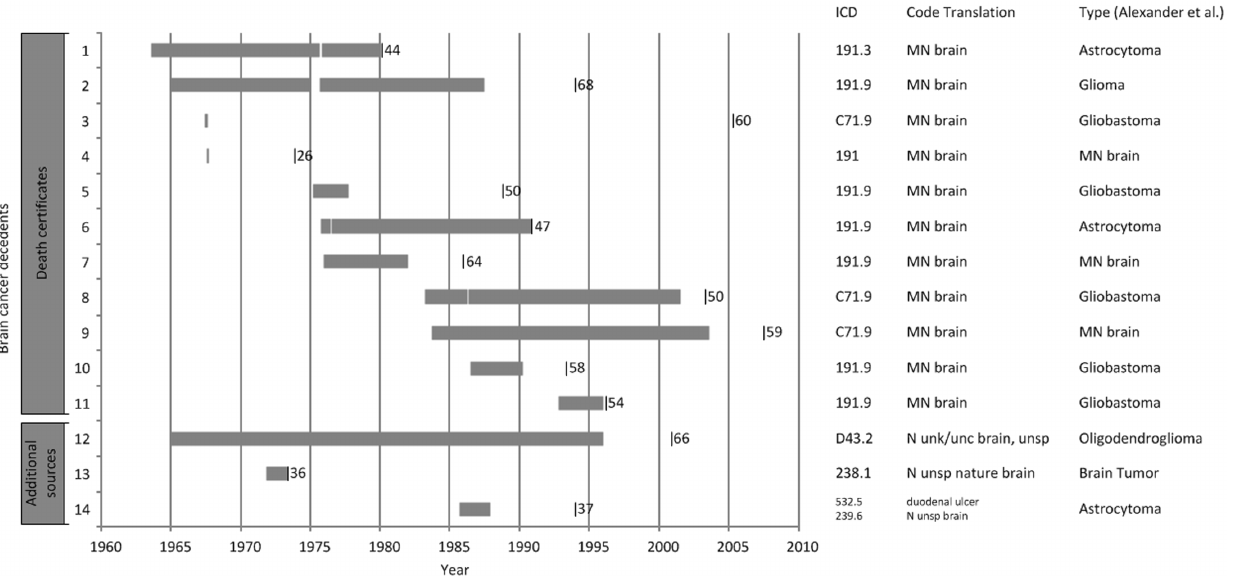
Figure 2. Years worked at the Spring House facility, death date, and age at death for workers identified as having died of brain cancer relying only on NDI and death certificates for cause of death information or relying on additional information not included on death certificates. Gray bars represent years worked at the Spring House facility. The vertical black lines indicate the death date. The numbers specify age at death. The International Classification of Disease (ICD) codes provided were provided by the National Death Index (NDI) or coded by a nosologist according to the ICD revision in effect when the death occurred. ICD code translations are provided along with the type of brain cancer as determined by Alexander et al. in the original Spring House mortality study.